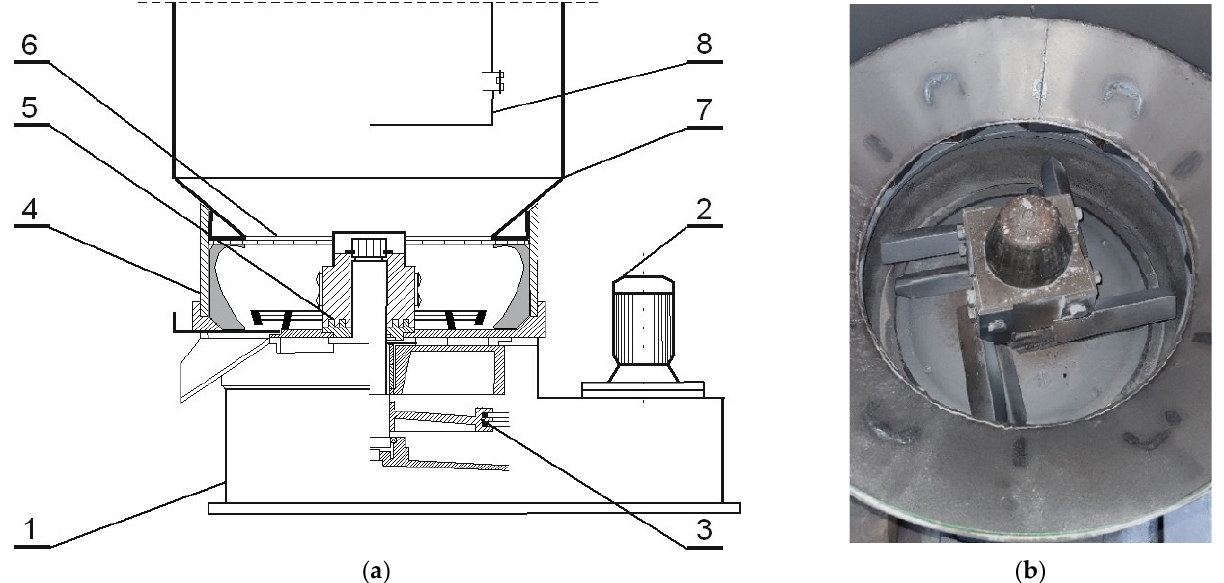
Figure 1. Experimental Rd-6 rotor regenerator: ( a ) schematic diagram [1—base of device; 2—drive motor; 3—belt transmission; 4—regenerator circular ring; 5—rotor with abrasive and crushing elements; 6—air guide; 7—dust-collection chamber casing; 8—inspection door]; ( b ) inside regenerator.